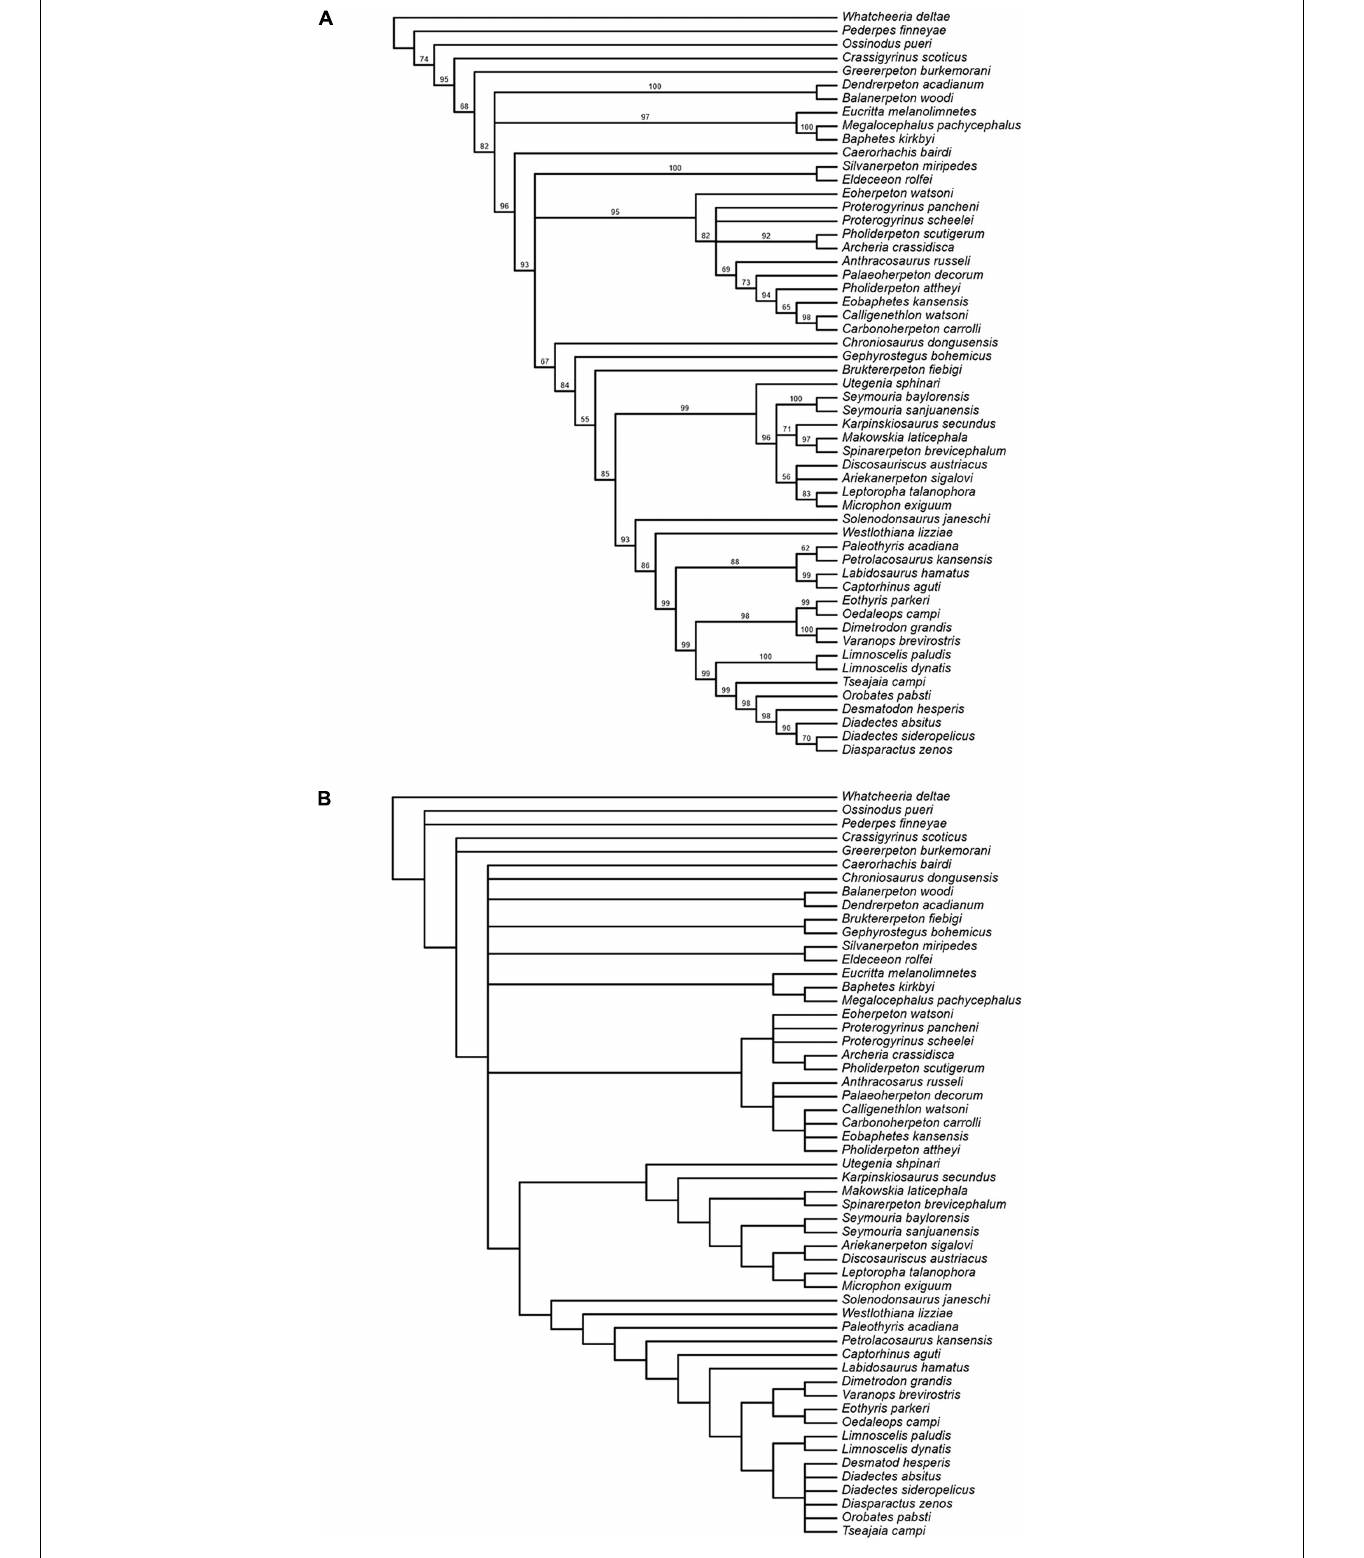
FIGURE 15 | (A) Results of Bayesian analysis; clade credibility tree with posterior probability (credibility) values for node support appended to branches. (B) Strict consensus of 78 most parsimonious trees from analysiswith unweighted characters after deletion of inner ear characters.